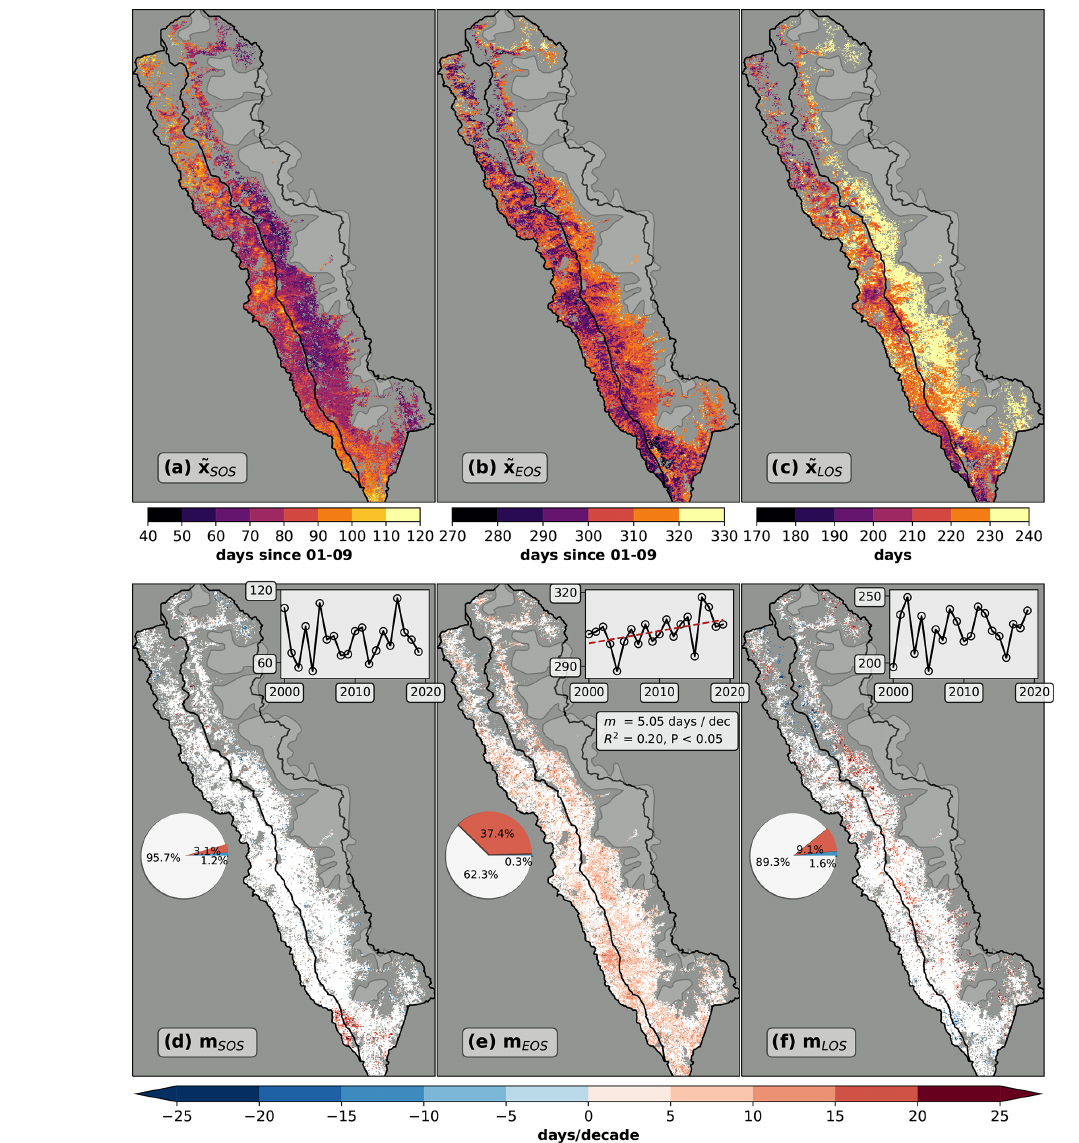
Figure 6. Maps of LSP characteristics and trends. First row (a–c) : median values of (a) SOS, (b) EOS and (c) LOS for the RSB. Only pixels where the full time series is available (20 seasons) are shown. Second row (d–f) : linear regression for the same parameters; maps show decadal slope of the same parameters; inset scatterplots show time series of the domain median values with regression statistics if the regression is significant ( P < 0.05). Only significant pixels ( P < 0.05) are shown, white color indicates non-significant pixels, while gray areas correspond to no data. Pie charts indicate relative percentages of significant pixels, where red color indicates a forward shift and blue color a backward shift of the LSP